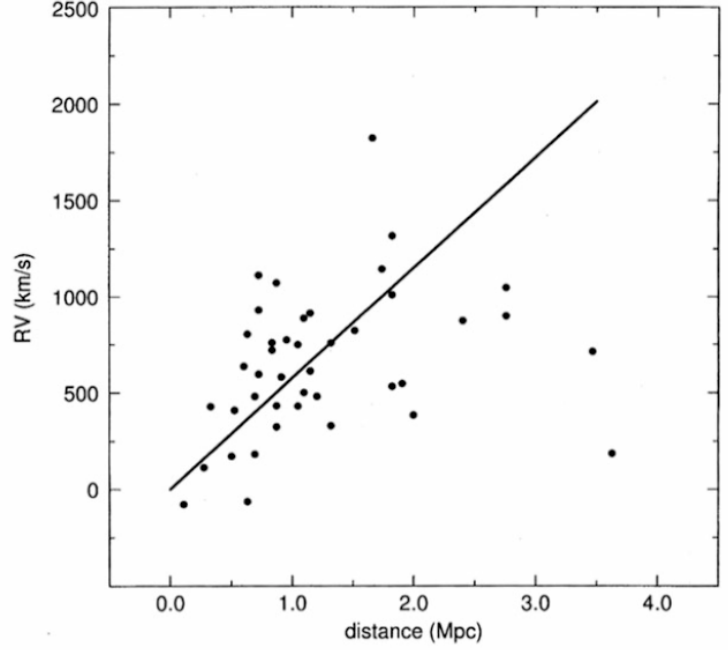
Figure 1. Observational data used by Lemaître and the line [18] fitting best with the data and which was used to calculate the value of H .